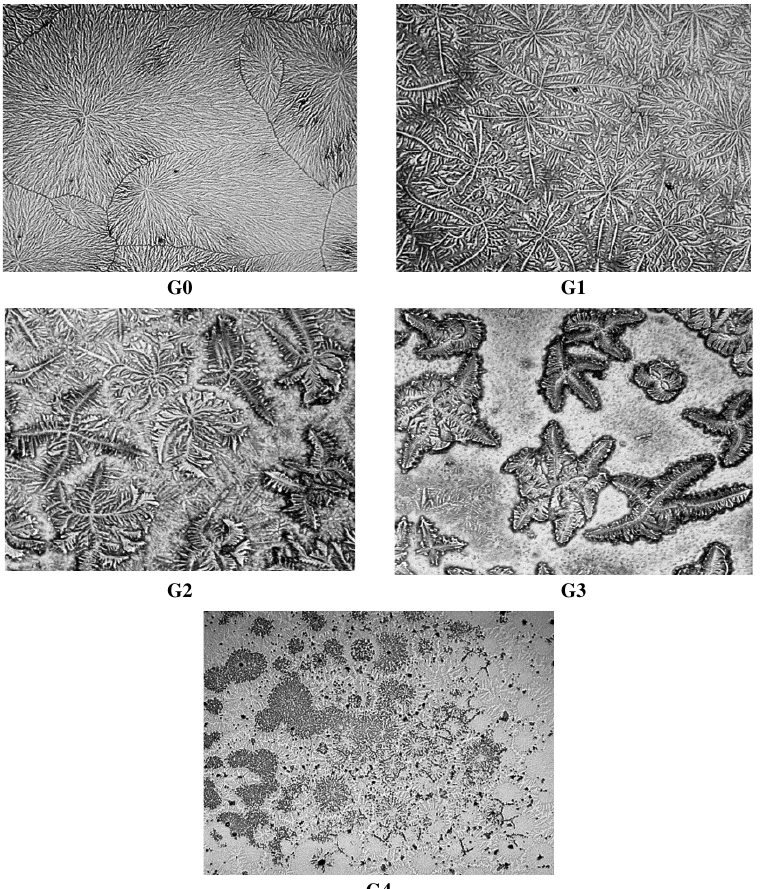
Fig. 3. Images after normalization and contrast